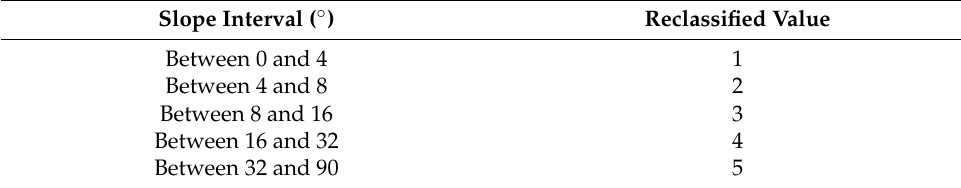
Table 2. Terrain slope classification.